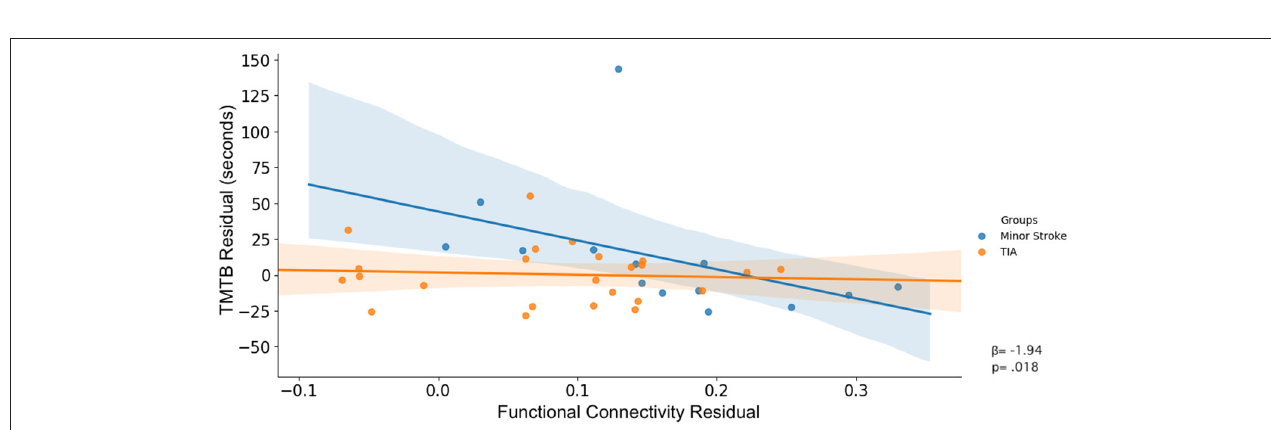
FIGURE 4 | Corrected interaction of rsFC between FPN and FPN, TMT-B performance and